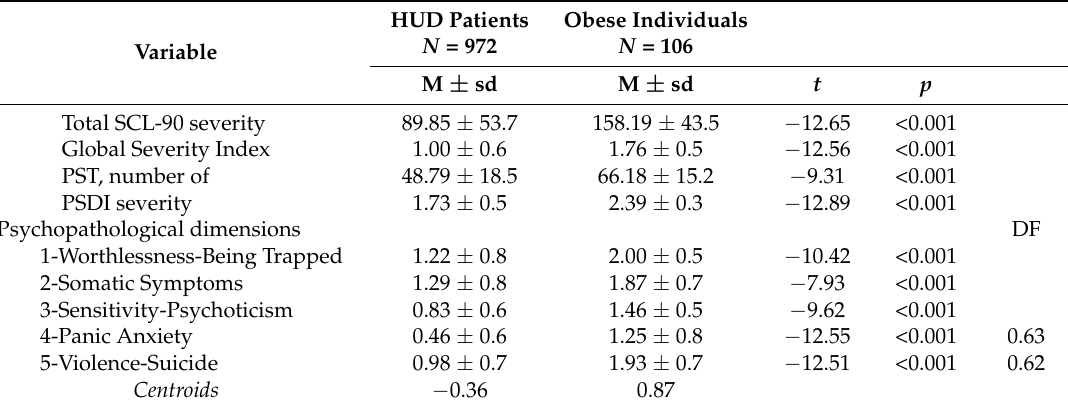
Table 1. Psychopathological severity in Heroin Use Disorder (HUD) patients and obese